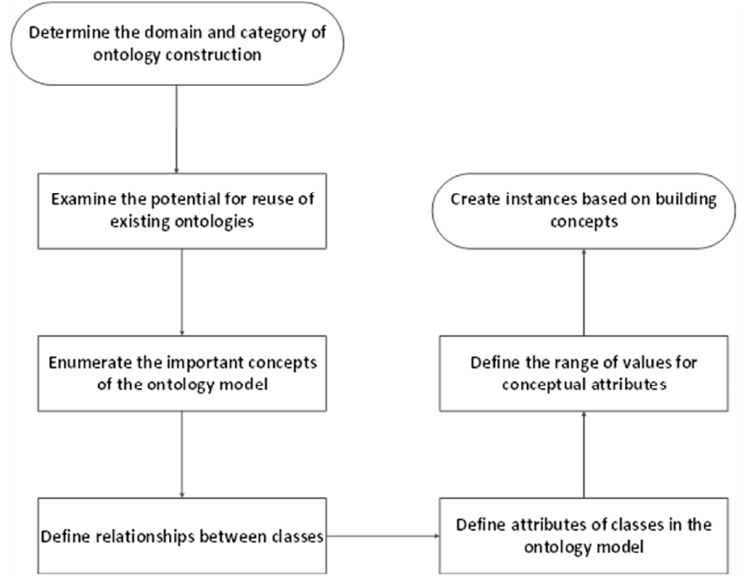
Figure 2. Seven-step construction process.